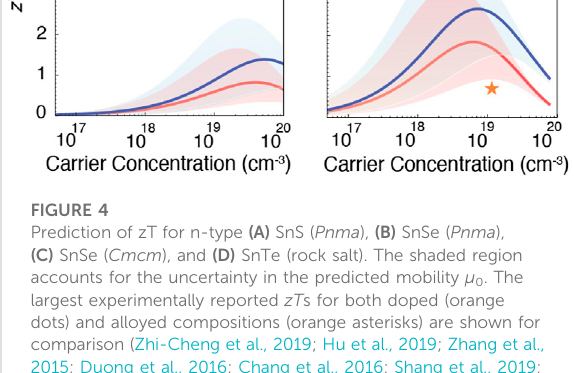
FIGURE 4 Prediction of zT for n-type (A) SnS ( Pnma ), (B) SnSe ( Pnma ), (C) SnSe ( Cmcm ), and (D) SnTe (rock salt). The shaded region accounts for the uncertainty in the predicted mobility μ 0 . The largest experimentally reported zT s for both doped (orange dots) and alloyed compositions (orange asterisks) are shown for comparison (Zhi-Cheng et al., 2019; Hu et al., 2019; Zhang et al., 2015; Duong et al., 2016; Chang et al., 2016; Shang et al.,